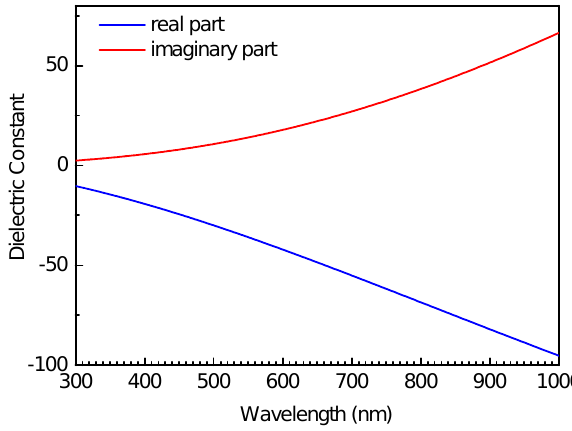
Figure 2. Wavelength dependence of the real and imaginary parts of the complex dielectric constant for liquid Ga used in the calculation of the scattering spectra of Ga